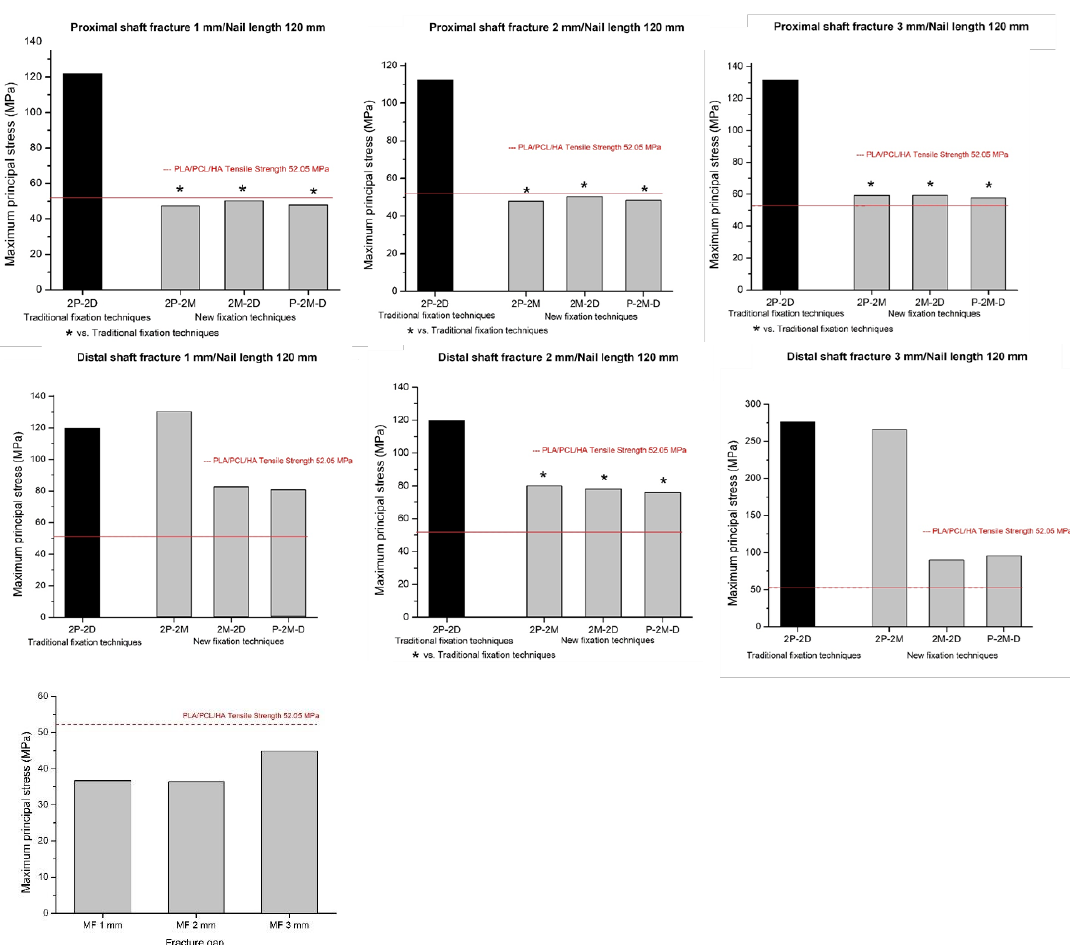
Figure 16. The maximum principal stress of the four locking screws in the composite interlocking nails with different fixation techniques and a different fracture gap in a proximal shaft fracture (top row), distal shaft fracture (middle row), and middle shaft fracture (bottom row).